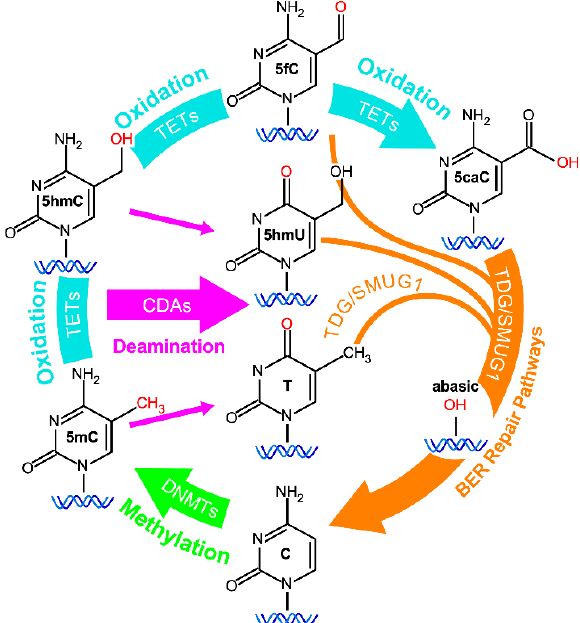
Figure 1. Cytosine methylation/demethylation cycle. Cytosine (C) can be modified by DNA methyltransferases (DNMT) at the 5 position to generate 5-methylcytosine (5mC). 5mC may be sequentially oxidized by Ten Eleven Translocation methylcytosine dioxygenase (TET) to generate first 5-hydroxymethylcytosine (5hmC), and then 5-formylcytosine (5fC) and 5-carboxycytosine (5caC). Alternatively, 5mC or 5hmC may be deaminated by cytidine deaminase (CDA) to generate thymidine (T) or 5-hydroxymethyluracil (5hmU), respectively. The base excision repair pathway (BER), along with thymine DNA glycosylase (TDG) and single-strand-selective monofunctional uracil-DNA glycosylase (SMUG1), is required for re-generation of cytosine.